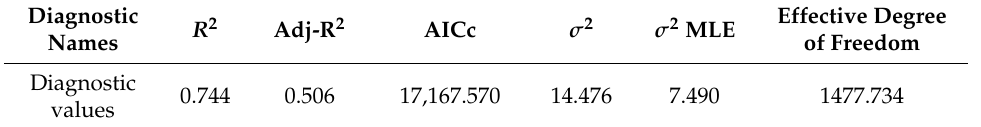
Table 7. The geographically weighted regression (GWR) model diagnostic results.